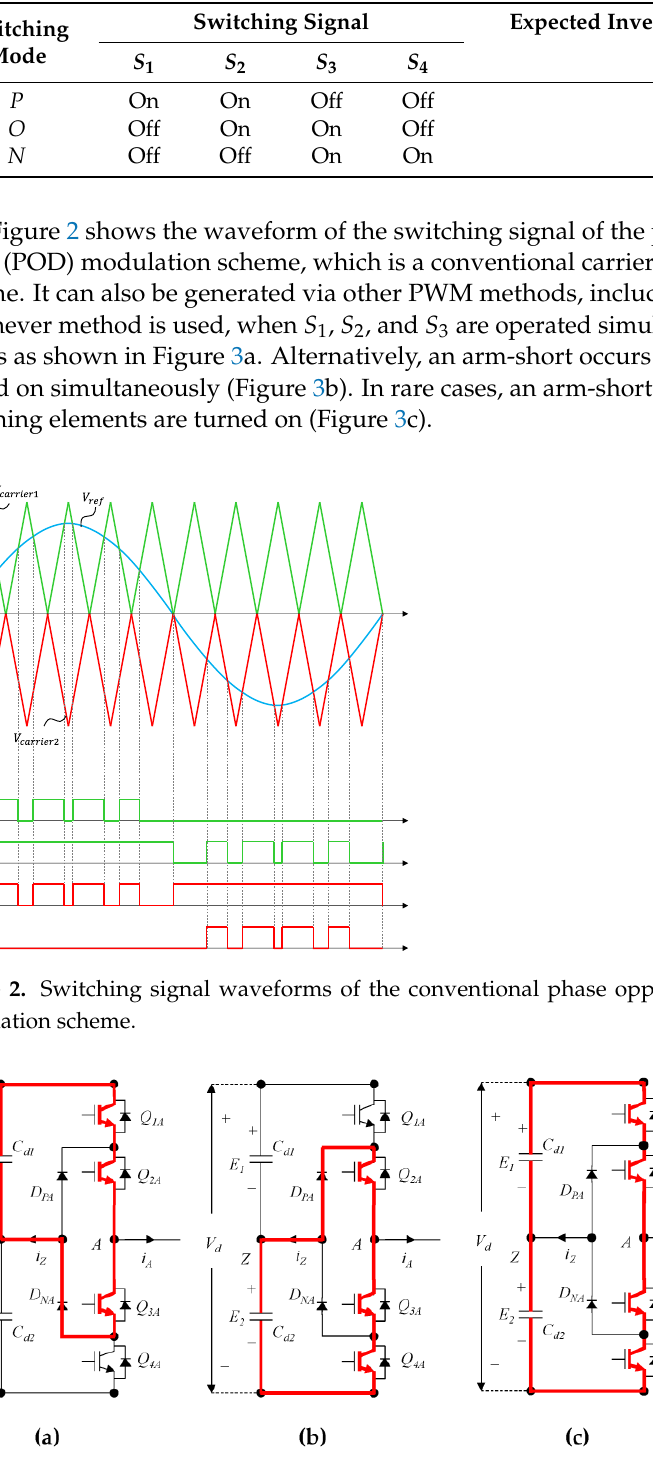
Table 1. Switching mode of the conventional switching method.